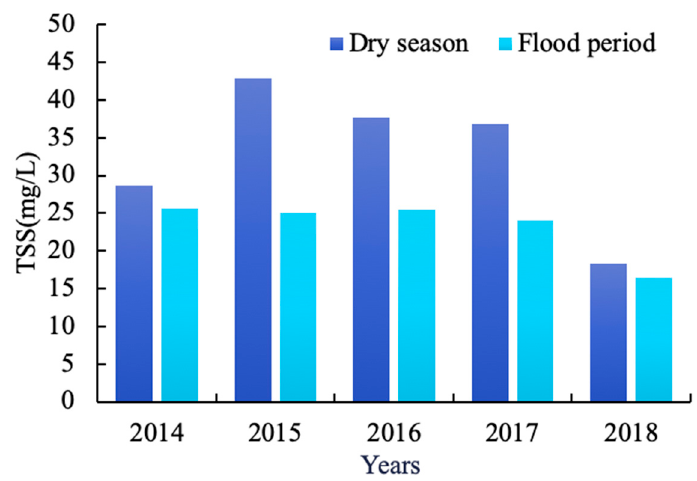
Figure 8. Comparison of annual average TSS concentrations in the reservoir area of Shijiao Township from 2014 to 2018 in different seasons.